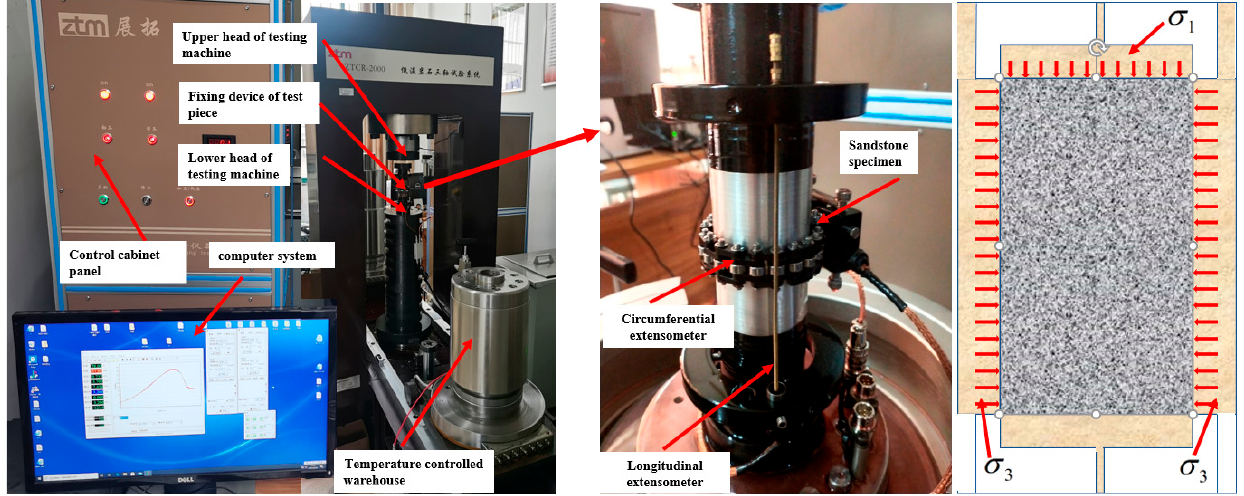
Figure 3. Stress diagram of the triaxial test system and test piece.